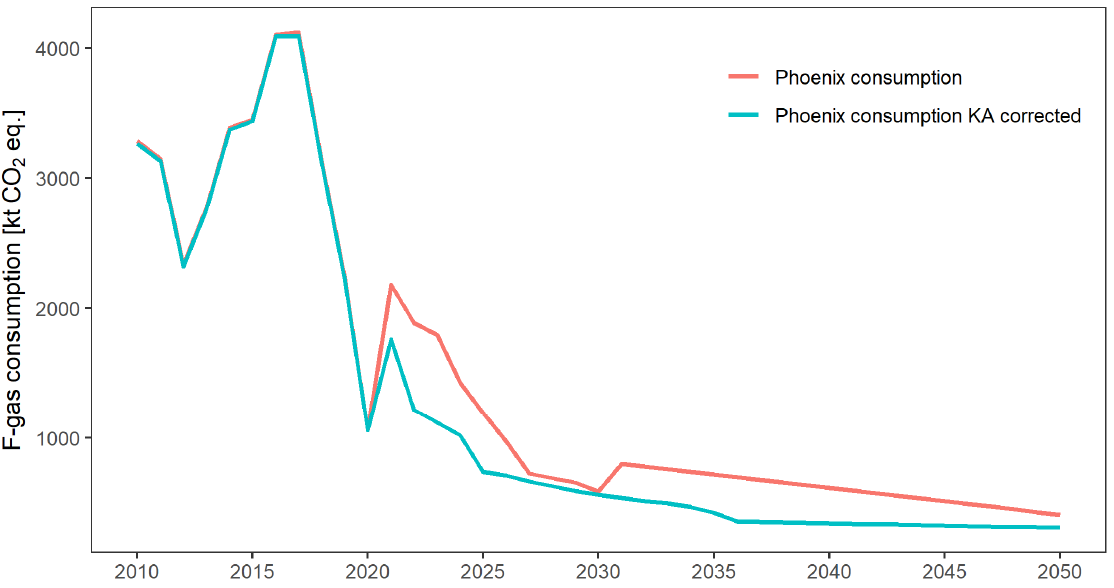
Figure 1. Consumption of F-gases inputted into the Phoenix model, both with and without KA cor- rection.